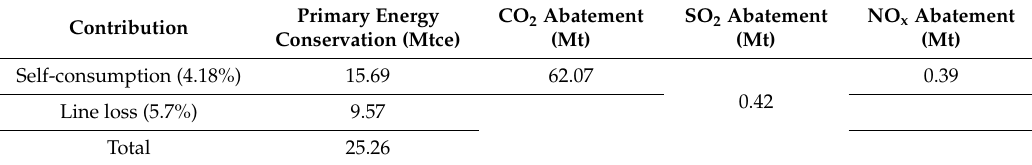
Table 5. Potential from technical and operational